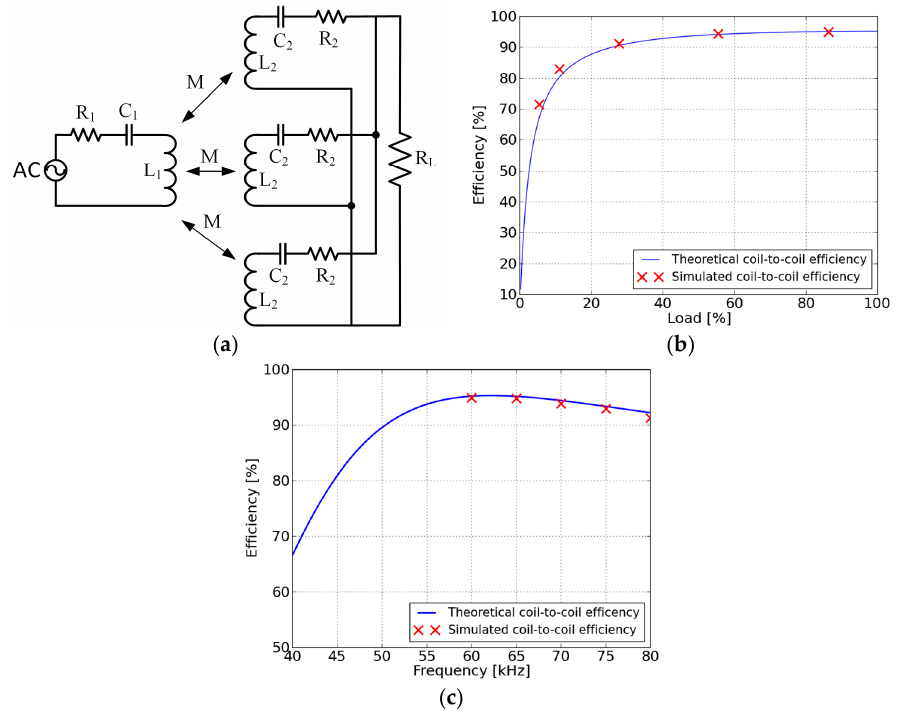
Figure 8. Equivalent coil-to-coil model and its theoretical and FEA simulated coil-to-coil efficiencies: ( a ) equivalent circuit model; ( b ) efficiency vs. load; ( c ) efficiency vs. operating frequency.